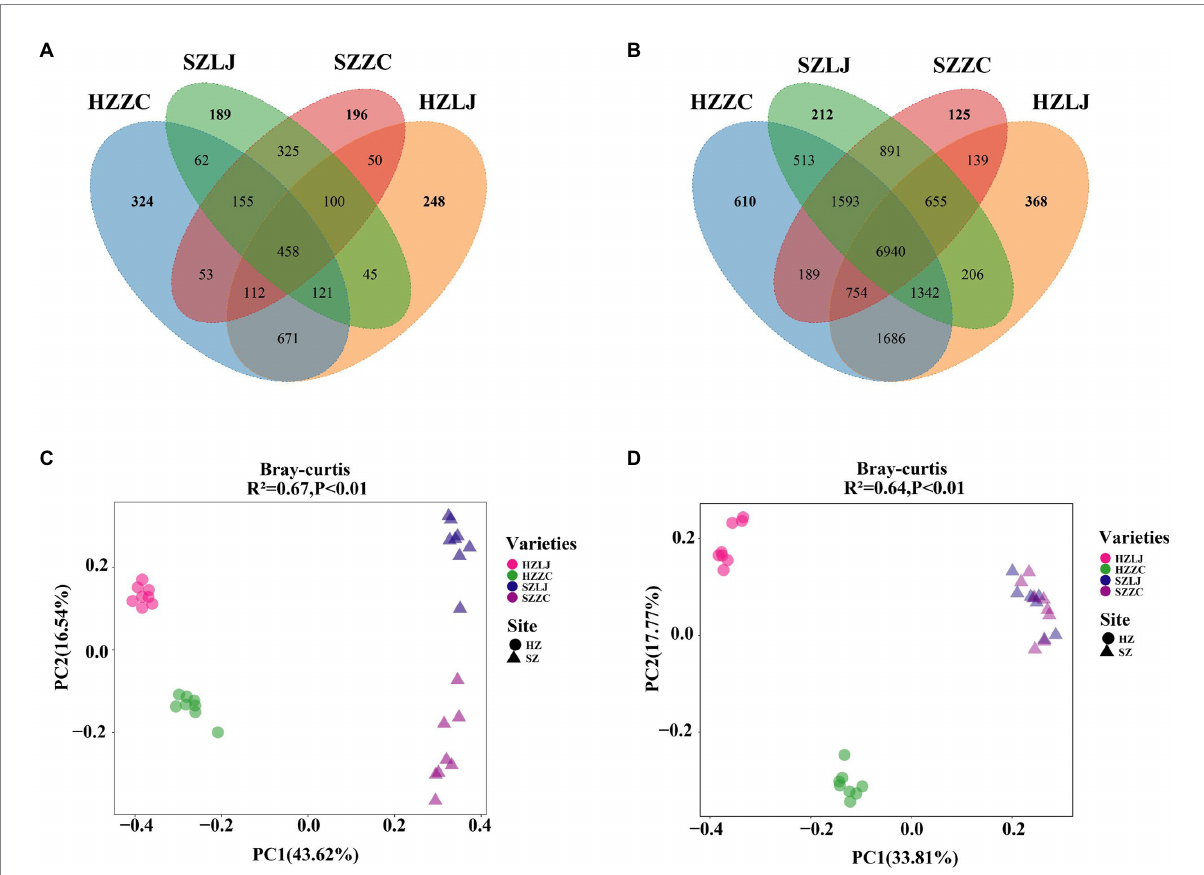
FIGURE 4 Differences in rhizosphere microbial communities of two tea varieties in different locations. (A) The rhizosphere bacteria in HZ-LJ43, HZ-ZC108, SZ-LJ43 and SZ-ZC108 shared OTUs and unique OTUs. (B) The rhizosphere bacteria in HZ-LJ43, HZ-ZC108, SZ-LJ43 and SZ-ZC108 shared OTUs and unique OTUs. (C,D) Principal Coordinates Analysis (PCoA) using the unweighted Unifrac distance metric. The values of PC1 and PC2 are the percentages that can be explained by the corresponding